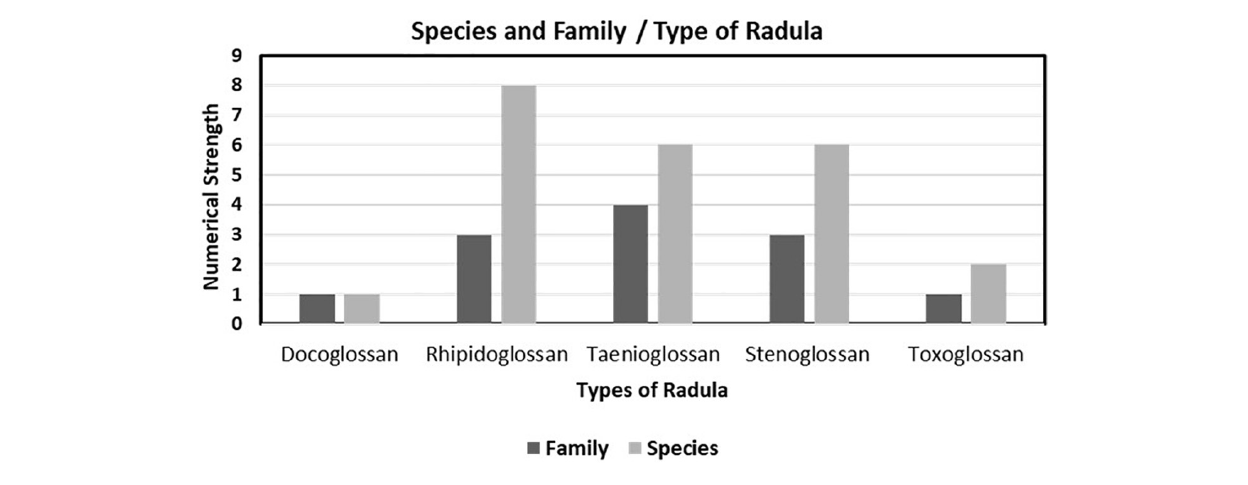
identified. They all have a single functional and primarily analogous (interfamily level) central tooth. Most of the individuals have one lateral tooth while very few consist of more than one lateral tooth. In the case of marginal teeth, most have been observed with a gradient change in the pattern of tooth, and the first lateral tooth is, in most cases, dominated or bigger than others ( Table 1 ).